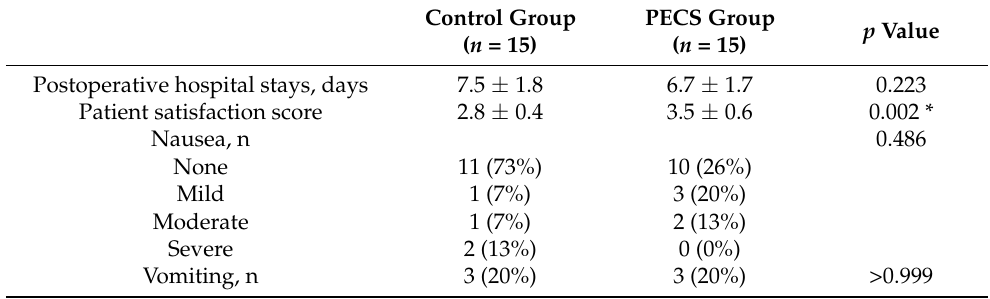
Table 3. Postoperative